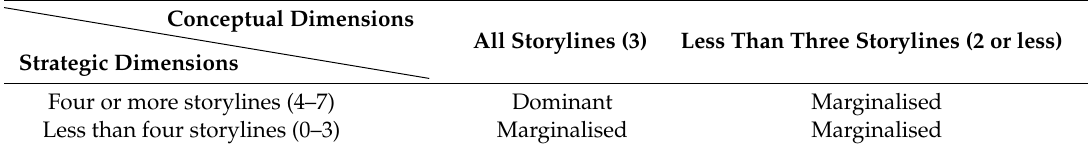
Table 2. Rules to determine the degree of discourse influence according to the representation of storylines discussing REDD+ conceptual and strategic dimensions as they appear in selected policy documents. The number of storylines is in brackets. Source: own